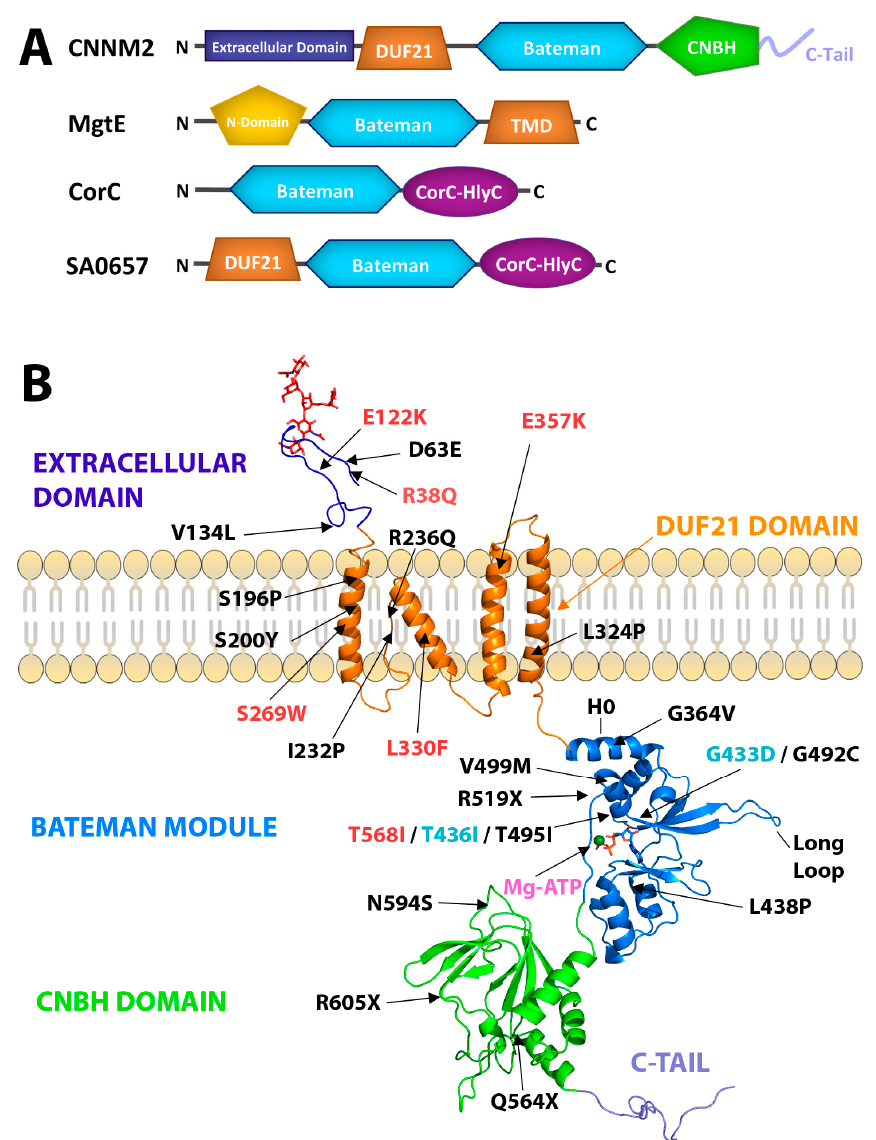
Figure 1. Structure of CNNMs. ( A ) Domain distribution in a related cystathionine β -synthase CBS domain containing metal ion transporters, including CNNM2. The Bateman module (in blue) plays a regulatory role in all the proteins shown. The DUF21 domain represents a major part of the transmembrane domain (TMD) (orange) and is thought to contain from three to four α -helices. CNBH domain is in green. The N-terminal extracellular region of CNNM2 is predicted to be β -strand-enriched (deep purple). The bacterial MgtE channel shares the presence of a CorC-HlyC domain (purple) with CorC and with other proteins such as the bacterial SA0657 protein [57]. ( B ) The panel shows in ribbons the three-dimensional structure of the isolated domains. The structures of the Bateman module and the CNBH domain were extracted from crystallographic data [43,45,58,59]. The representation of the DUF21 domain corresponds to an in silico model [22]. The CNNM representation is as follows: The N-terminal extracellular domain (dark blue) shows the glycosylation in red; the transmembrane α -helixes are represented in orange. In the intracellular region, the Bateman module (PDB code: 4P1O) is represented in blue; bound MgATP is in pink. The CNBH domain (PDB code: 6DJ3) is in green. The unstructured terminal C-tail is in purple. The locations of all known pathological mutations reported for CNNMs are indicated by arrows and in different colors depending on the variant protein: CNNM2 (red), CNNM3 (cyan), and CNNM4 (black). Helix H0 connects the Bateman module with the DUF21 domain.